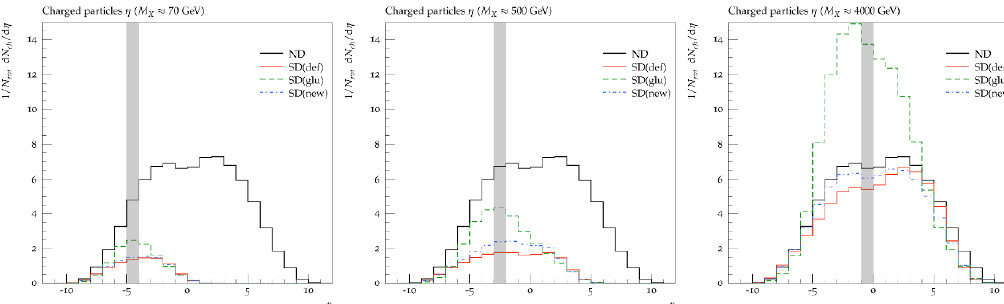
Figure 6 . Pseudo-rapidity distribution of charged particles for di(cid:11)erent di(cid:11)ractive masses for the default single di(cid:11)raction in P YTHIA 8 (red solid lines), the modi(cid:12)cations made in [9] (green dashed lines) and the new modi(cid:12)cations presented here (blue dash-dotted lines). Left, centre and right histograms correspond to M X values of 70, 500, and 4000 GeV respectively. For comparison the (cid:25) results from non-di(cid:11)ractive P YTHIA events at p s = 5 TeV is shown as the solid black line. The shaded areas in the (cid:12)gure indicate the pseudo rapidity intervals where the comparisons between SD and ND particle distributions in section 5.2 were